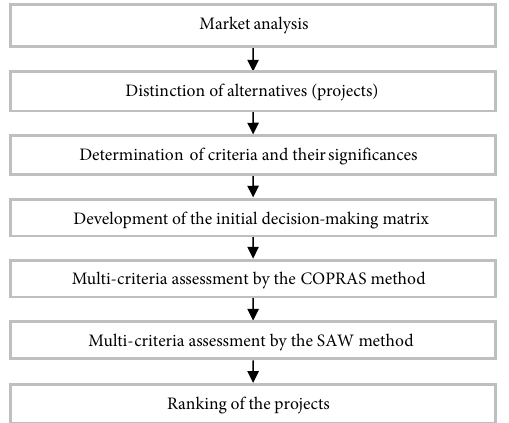
(8) Figure 1. Flowchart of the assessment